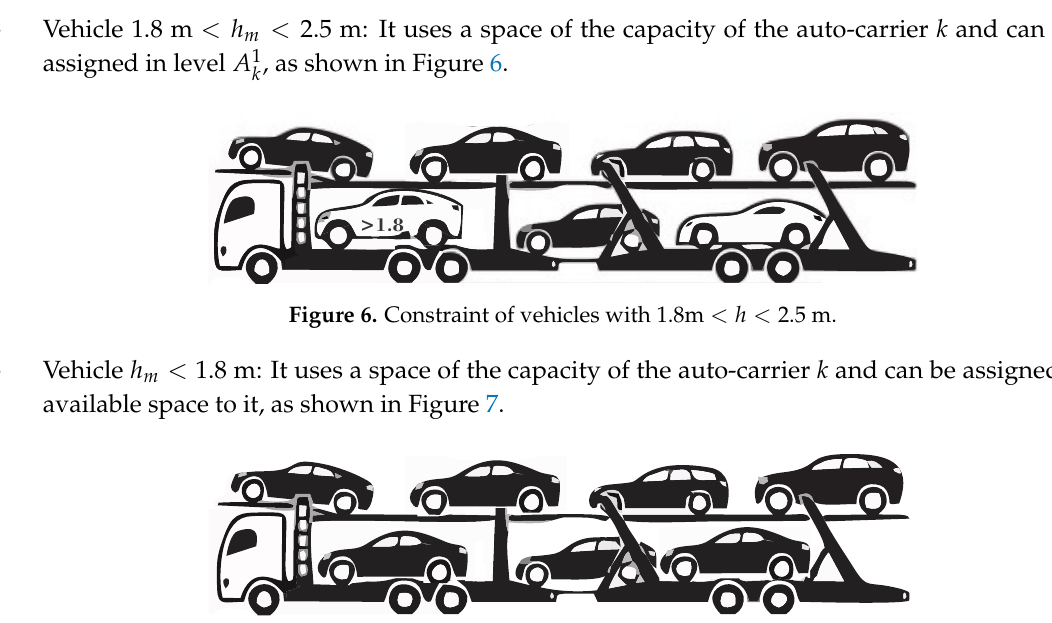
Figure 7. Constraint of vehicles with h < 1.8